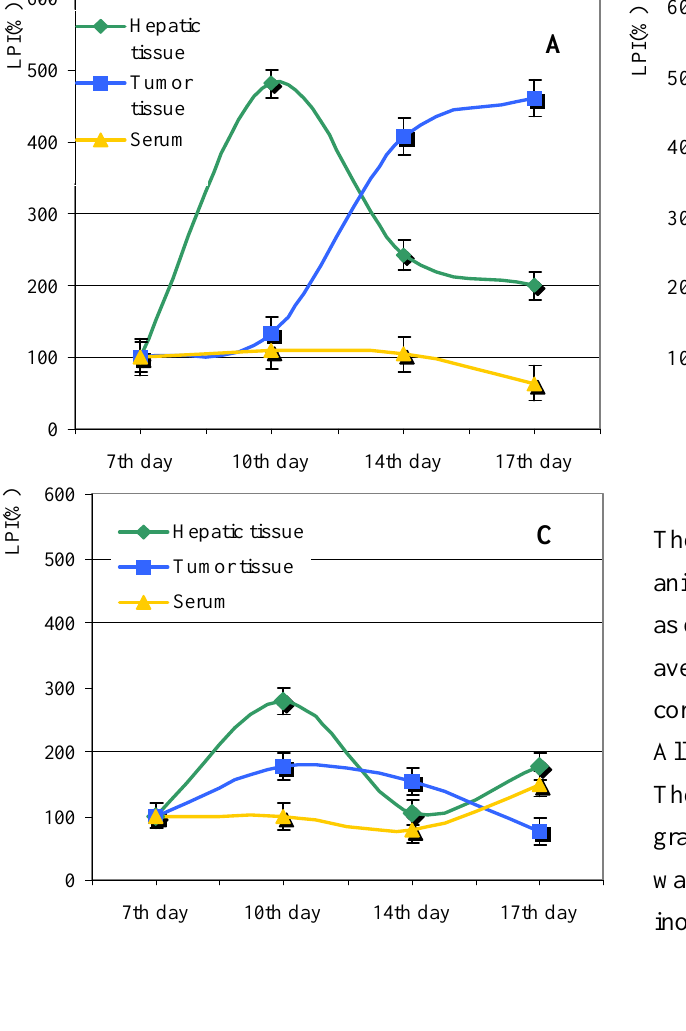
Figure 2 . Effect of Lonicera caerulaea berry extracts upon lipid peroxid extration index